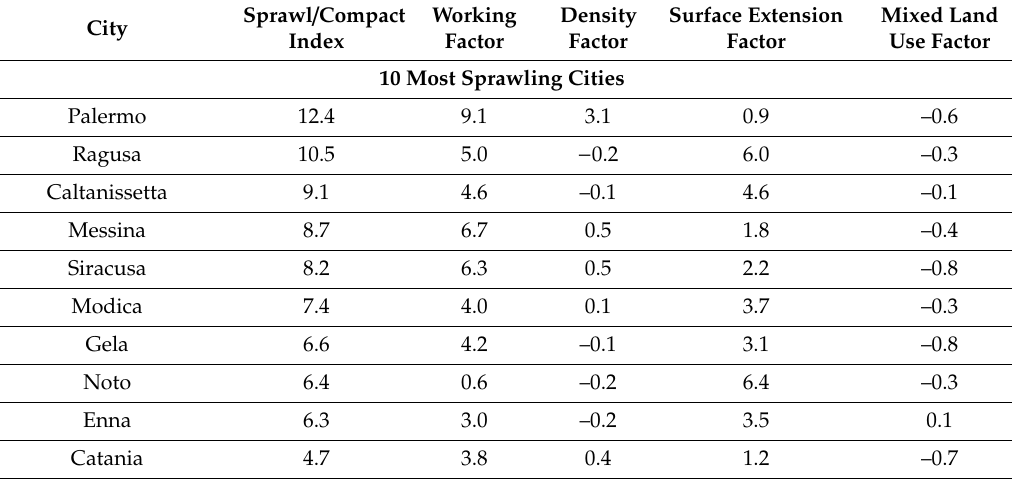
Table 2. Sprawl / compactness score for most 10 sprawling and 10 most compact Sicilian